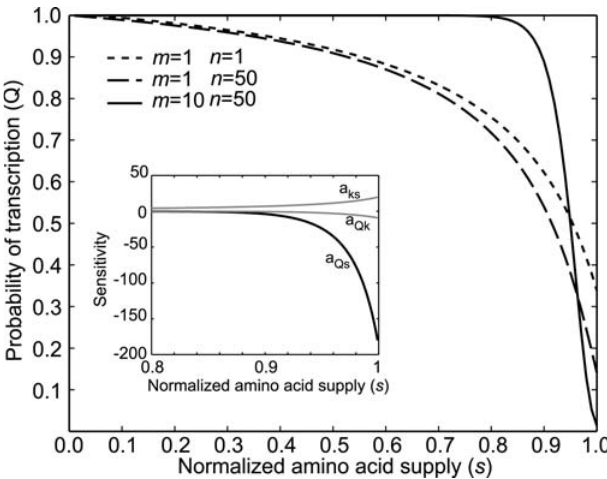
Figure 3. The Probability Q of Read-Through of the Leader Is Plotted as a Function of the Signal s For the curve with m ¼ 10, k is given by Equation 9, and for the curves with m ¼ 1, k is one-tenth of this value. q 9 ¼ 1 s (cid:1) 1 for all curves. The usage frequency of the amino acid in proteins is f ¼ 1/20, and the maximal rate of codon translation at full supply of amino acid is k max ¼ 20 s (cid:1) 1 . Insert: The contributions of the two factors to the sensitivity a Qs ¼ a Qk a ks is illustrated for the case with m ¼ 10 and n ¼ 50. a ks approaches 1/ f as s ! 1. The asymptotic behavior of a Qk is described in Figure 2. DOI: